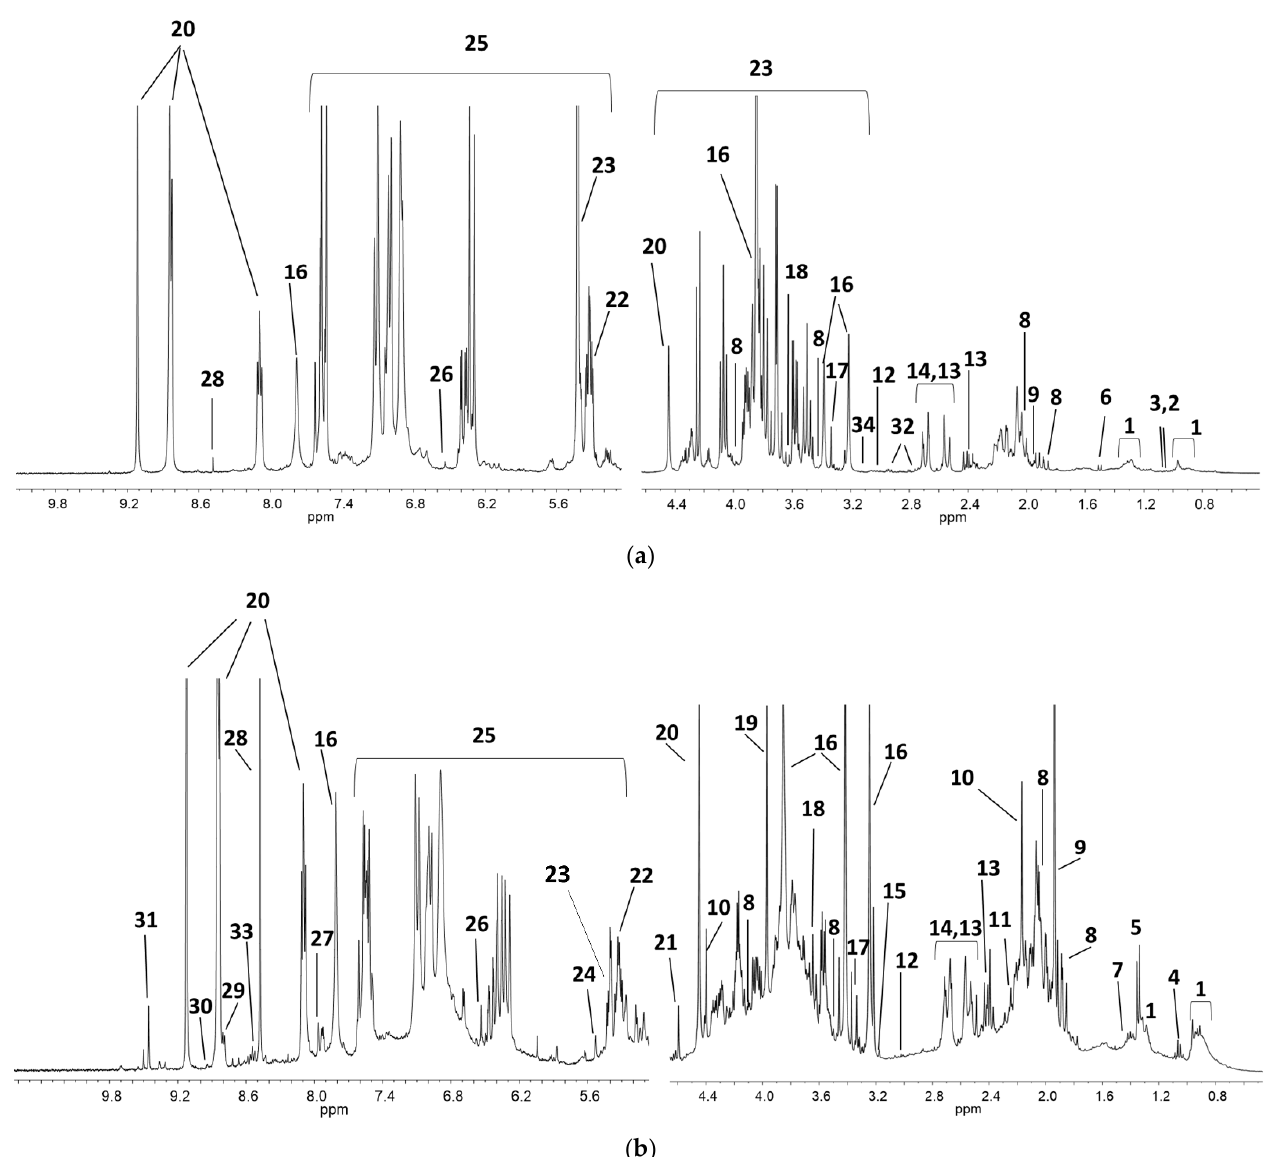
Figure 1. 1 H NMR spectra (400 MHz) of water-soluble green ( a ) and roasted ( b ) coffee beans. (1) fatty acids; (2) isoleucine; (3) valine; (4) propionic acid; (5) lactic acid; (6) alanine; (7) unknown1; (8) quinic acid; (9) acetic acid; (10) hydroxy acetone; (11) acetone; (12) gamma-aminobutyric acid (GABA); (13) malic acid; (14) citric acid; (15) choline; (16) caffeine; (17) theophylline; (18) myo-inositol; (19) glycolic acid; (20) trigonelline; (21) 2-furylmethanol; (22) 5-caffeolylquinic acid (5-CQA); (23) sucrose; (24) citraconic acid; (25) chlorogenic acids; (26) fumaric acid; (27) xanthine; (28) formic acid; (29) N-methylpyridinium (NMP); (30) nicotinic acid; (31) 5-hydroxymethylfurfural (5-HMF); (32) anserine; (33) methyl xanthines; (34) putrescine.